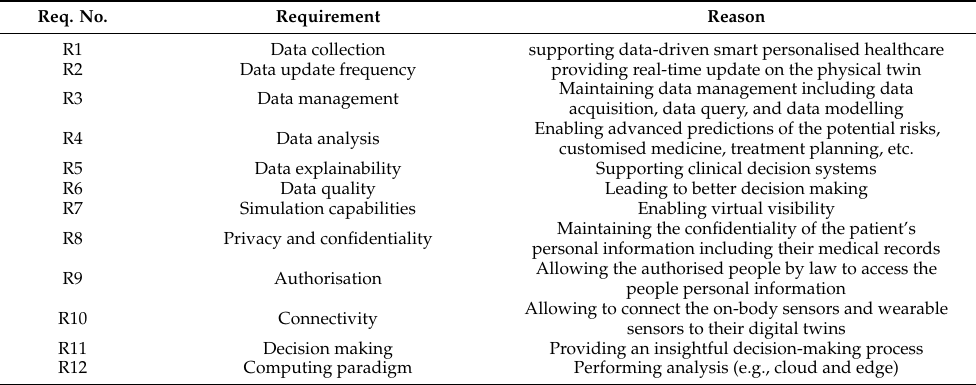
Table 5. High-level requirements for a smart personalised healthcare system based on PDT. Req.